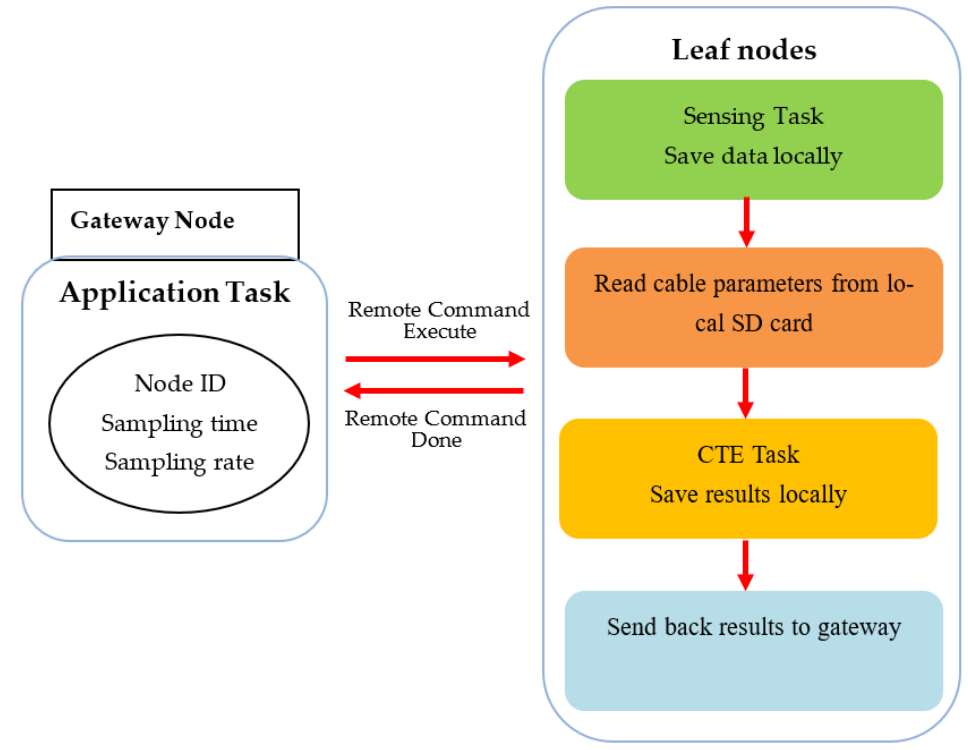
Figure 9. Flowchart of cable tension estimation with Xnode system.